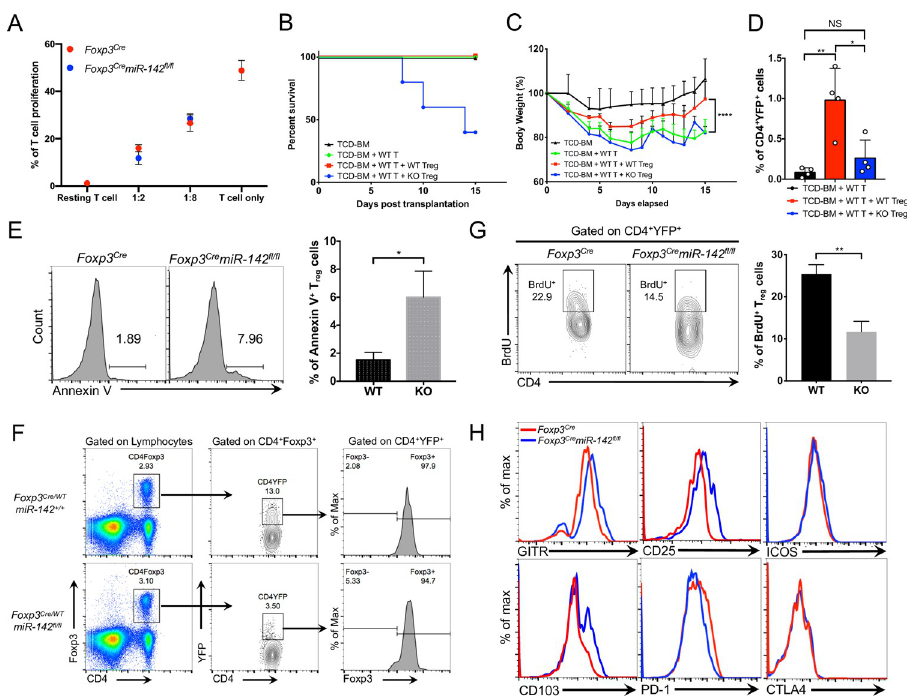
Fig 3. miR-142 ablation impairs suppressive function and homeostasis of T reg cells. ( A ) in vitro T reg suppression assay. Purified CD4 + T conv cells were loaded with CTV dye and incubated with FACS-sorted T reg cells from Foxp3 Cre (red dots) and Foxp3 Cre miR-142 fl/fl (blue dots) spleens ( n = 3) in the presence of beads coated with anti-CD3 and anti- CD28 specific antibodies. After 3 days, the rate of T conv cell proliferation was determined by flow cytometry as dilution of the CTV dye. Several T reg to T conv cell ratios were analyzed as indicated in the graph. Unstimulated T conv cells were used as control. ( B ) Survival of mice in aGVHD model. Lethally irradiated BALB/c recipient mice were transplanted with T-cell–depleted bone marrow from C57BL/6J mice (TCD-BM), Thy1.2 + CD4 + T cells from C57BL/6J spleens (WT T), and CD4 + YFP + T reg cells derived from either Foxp3 Cre (WT) or Foxp3 Cre miR-142 fl/fl (KO) spleens ( P = 0.0096; n = 5 per group). ( C ) Body weight analysis of mice in aGVHD model. Mouse grouping as in B ( n = 5 per group). ( D ) Frequency of donor Foxp3 Cre (WT) or Foxp3 Cre miR-142 fl/fl (KO) CD4 + YFP + T reg cells in spleens of BALB/c recipient mice on day 17 after BMT ( n = 4 for all groups). ( E ) Left panel, FACS analysis of activation-induced cell death in splenic Foxp3 Cre and Foxp3 Cre miR-142 fl/fl T reg cells. Apoptotic T reg cells were detected by Annexin V staining upon stimulation with anti-CD3 (1 μ g/ml) specific antibodies for 48 hours. Numbers indicate percentage of Annexin V + cells. Right panel, the frequency of Annexin V + Foxp3 Cre (WT) and Foxp3 Cre miR-142 fl/fl (KO) T reg cells ( n = 3 per group). ( F ) FACS analysis of CD4 + Foxp3 + T reg cells (left panels), YFP-Cre expression in CD4 + Foxp3 + T reg cells (middle panels), and Foxp3 expression in CD4 + YFP + miR-142 –sufficient and miR-142 –deficient T reg cells (right panels) from female Foxp3 Cre/WT miR-142 +/+ and Foxp3 Cre/WT miR-142 fl/fl mice. ( G ) Left panel, intracellular FACS analysis of BrdU incorporation into T reg cells isolated from Foxp3 Cre and Foxp3 Cre miR-142 fl/fl spleens. FACS plots were pregated on CD4 + YFP + T reg cells, and numbers indicate percentage of cells in the gate. Right panel, the frequency of BrdU + T reg cells in Foxp3 Cre (WT) and Foxp3 Cre miR-142 fl/fl (KO) spleens 16 hours after BrdU injection (1mg i.p.) ( n = 3 per group). ( H ) FACS analysis of cell surface markers on T reg cells isolated from Foxp3 Cre (red) and Foxp3 Cre miR-142 fl/fl (blue) spleens with anti-GITR, anti-CD25, anti-CD103, anti-PD-1, anti-CTLA-4, and anti-ICOS specific antibodies. Histograms were pregated on CD4 + YFP + T reg cells. Results are shown as mean ± SD. P values were calculated using log-rank test (B), 1-way ANOVA (C), and 2-tailed Student t test (D, E, G). � , P < 0.05; �� , P < 0.01; ���� , P < 0.0001; NS, not significant. The underlying numerical raw data can be found in S1 Data file. The underlying flow cytometry raw data can be found at the Figshare repository. aGVHD, acute graft-versus-host disease; BMT, bone marrow transplantation; CTV, cell trace violet; FACS, fluorescence activated cell sorting; KO, knockout; SD, standard deviation; T reg , regulatory T; YFP, yellow fluorescent protein; WT,